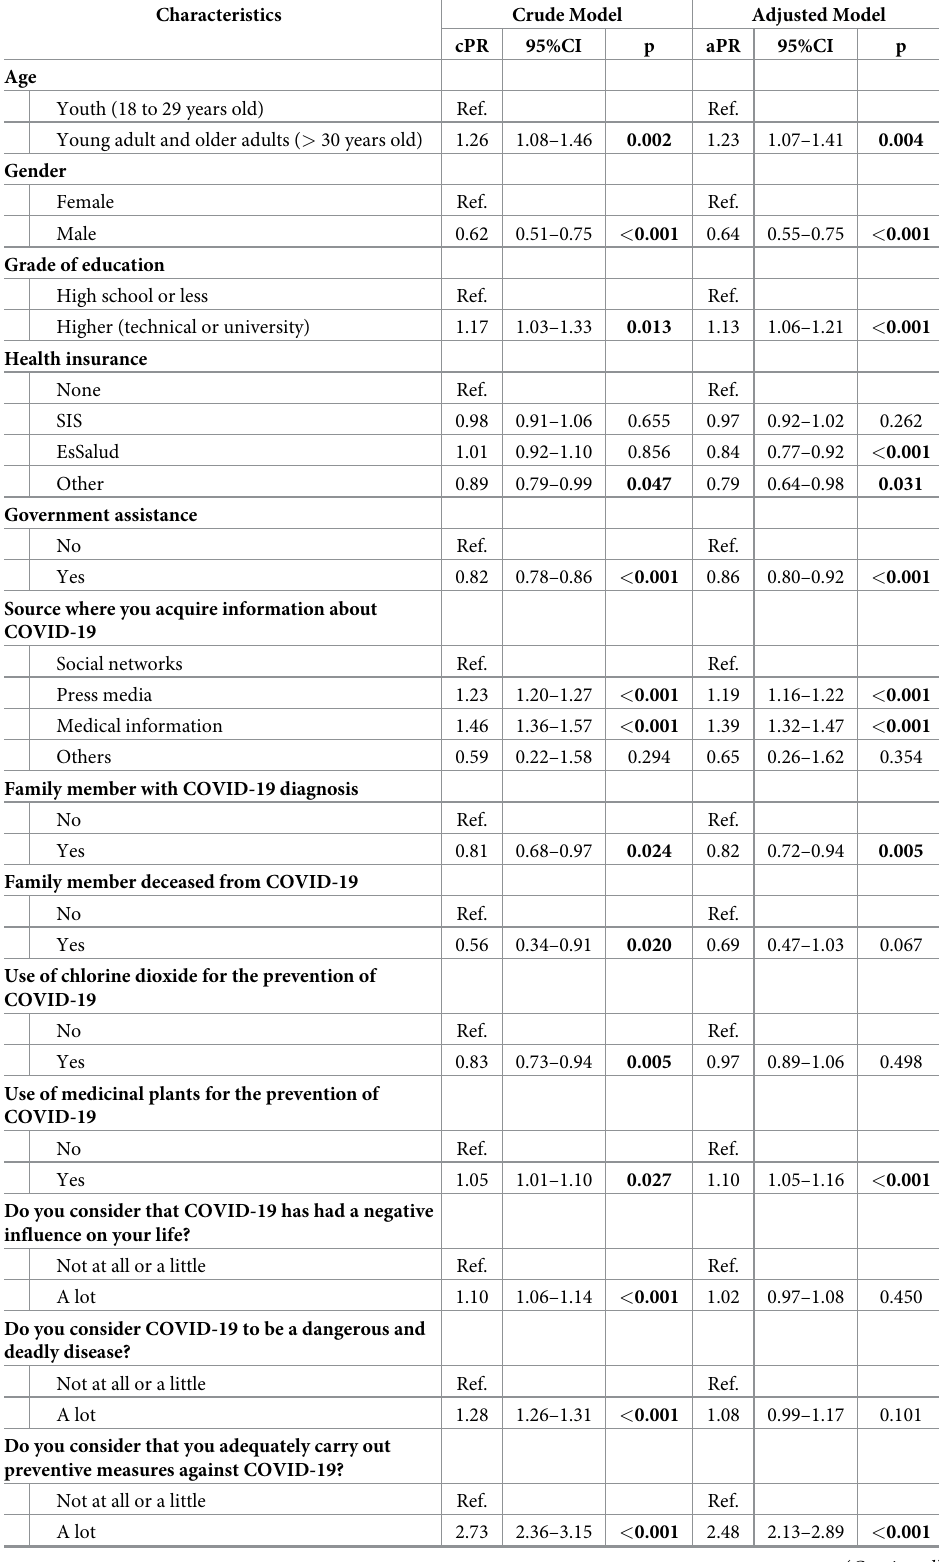
Table 4. Factors associated with prevention practices for COVID-19 infection in urban